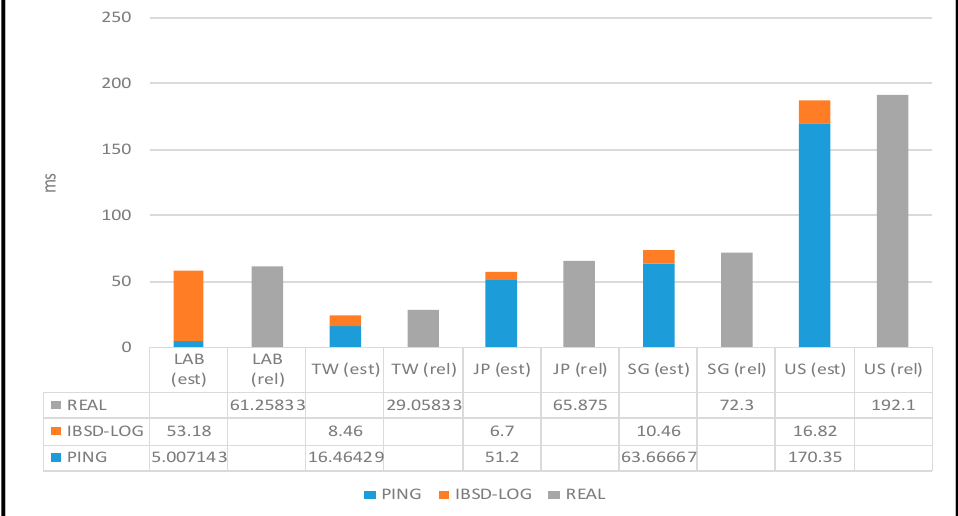
18 of 20 Figure 17. Cost of querying IRI for the information of known nodes. 4.3. Impact of Node Selection In this experiment, we deployed a simple computing service on two PCs in our lab and four virtual machines in the GCPs of different countries. Additionally, we ran an ap- plication to ask the deployed service about a client node (i.e., a PC in our lab). After the client node queried the IBSD node for the service nodes’ information, it obtained the re- cent execution time of each service node. Then, it estimated the network latency from the local to each service node through HTTP-ping and predicted the response time of each